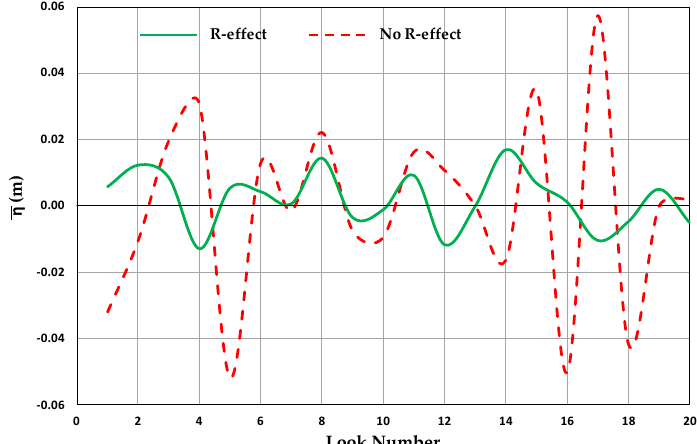
Figure 11. Sea surface height average values η by taking in account (solid green line), and by neglecting (dashed red line), the R-effect.